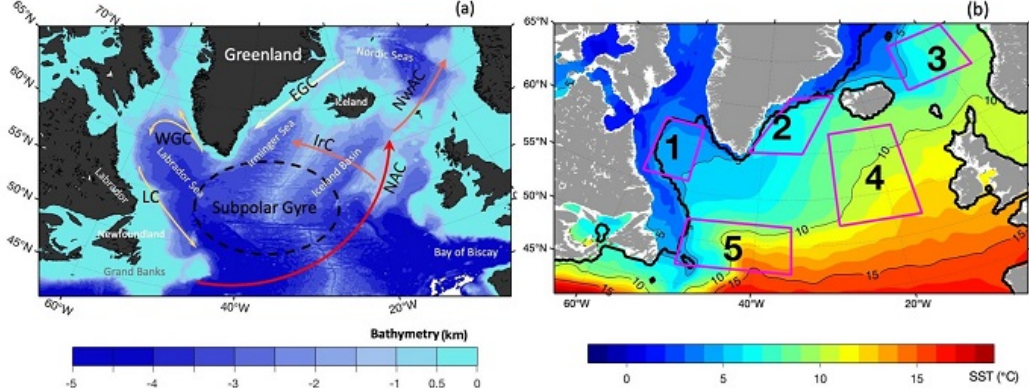
Figure 1. ( a ) Bathymetry of the subpolar North Atlantic with names that are referred to in the text. The superimposed, colored arrows illustrate major surface currents (counterclockwise): Eastern Greenland Current (EGC), Western Greenland Current (WGC), Labrador Current (LC), North Atlantic Current (NAC), Irminger Current (IrC), and Norwegian Atlantic Current (NwAC). ( b ) Mean sea-surface temperature averaged over 2016–2018. Data are from SMAP Jet Propulsion Laboratory (JPL). The thick black line denotes the ice margin. The five boxed areas denote the areas selected for analysis in Figures 7–10.